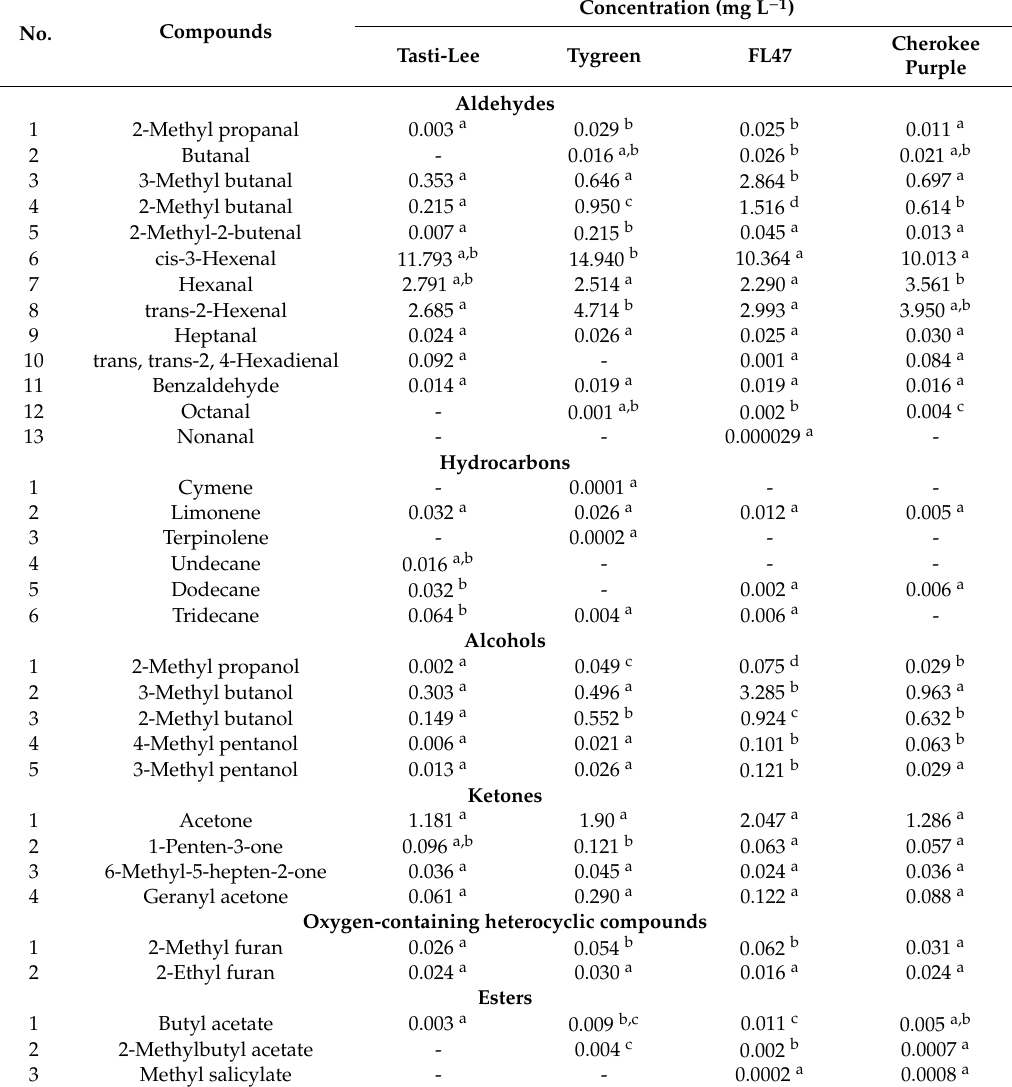
Table 4. Whole-fruit volatile profile of di ff erent tomato